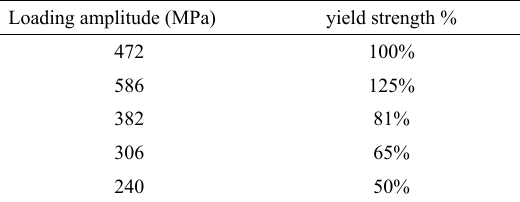
Table 2. Loading amplitude levels used for the fatigue tests.